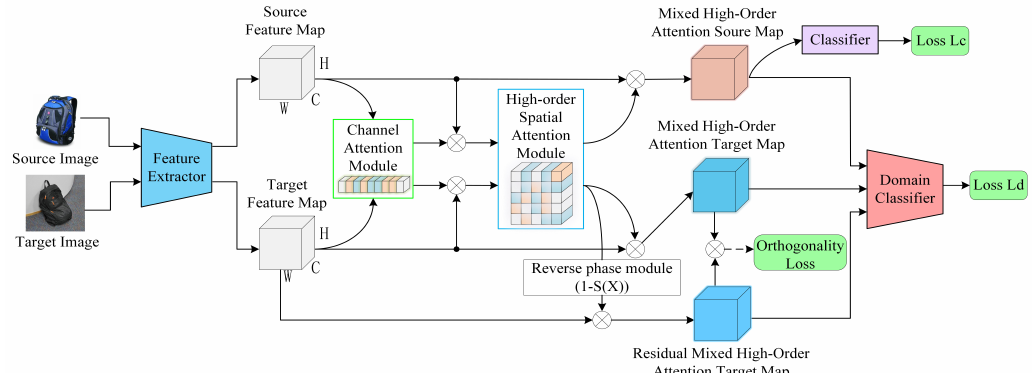
Figure 1. The proposed hybrid high-order triple-adversary network (HTAN) consists of six modules, including feature extractor G , label predictor C , domain discriminator D , complementary module ¯ G with orthogonal loss L orth , channel attention module F c and high-order spatial attention module F s